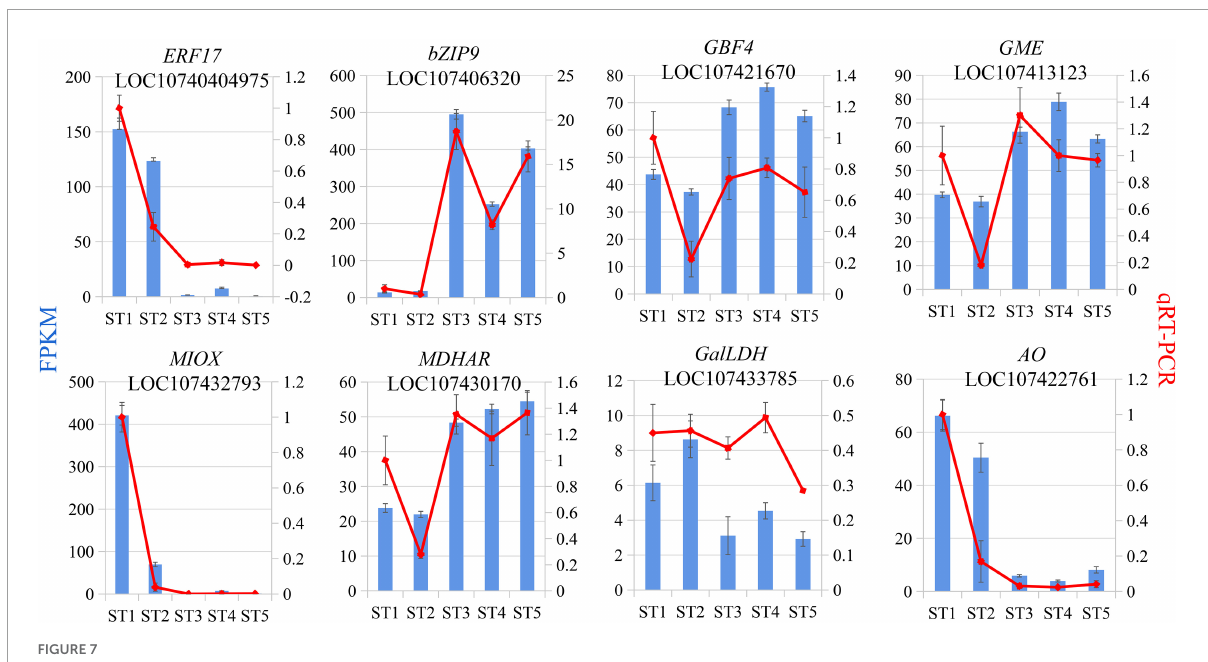
FIGURE7 The qRT-PCR validation